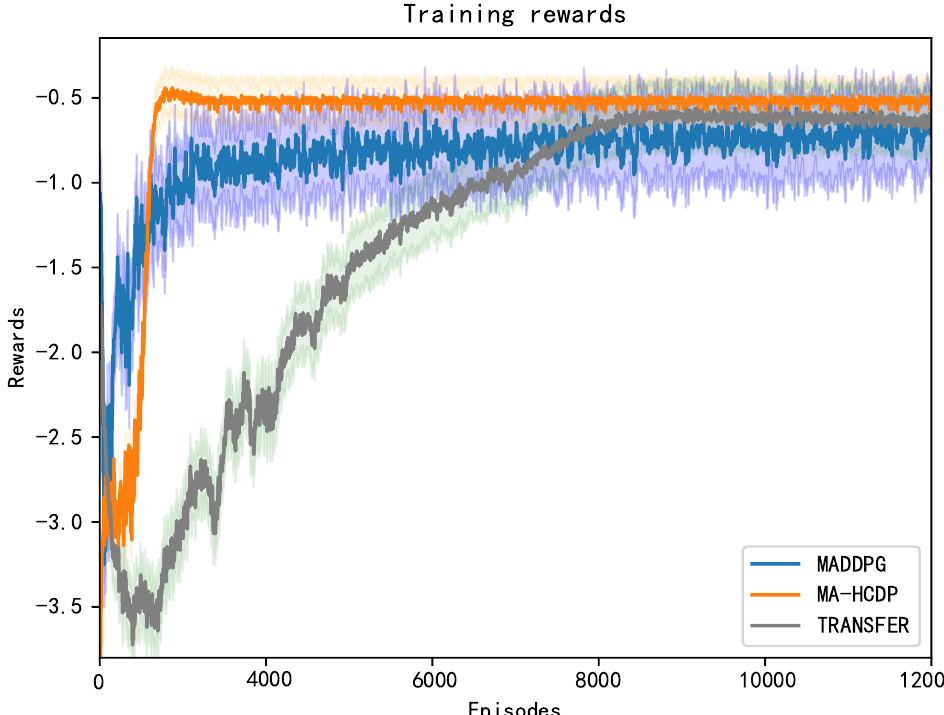
Figure 7. Simulation result in cooperative navigation with six